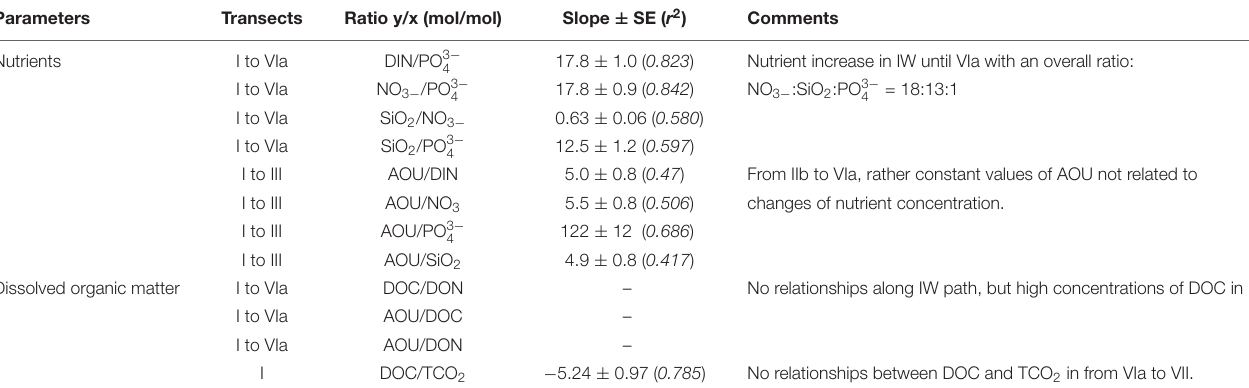
TABLE 2 | Linear relationships (slope, standard error, coefficient of determination) among AOU, nutrients and dissolved organic matter in IW, in selected groups of transects of OC2015 cruise.